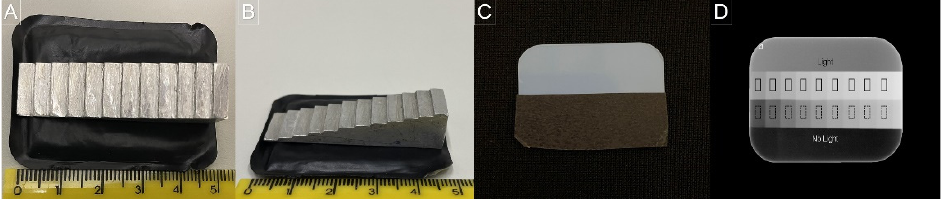
Figure 1. Setup for X-ray and light exposures. ( A , B ). Upper and lateral view of the aluminum step-wedge longitudinally fixed in the center of a sheathed size-2 PSP plate for X-ray exposure. ( C ). Upper view of the PSP plate with half of the sensitive surface covered with black paperboard for ambient light exposure. ( D ). Representative radiograph with the 18 ROIs: 9 in the exposed-to-light half (full-line rectangles) and 9 in the non-exposed-to-light half (dotted-line rectangles).